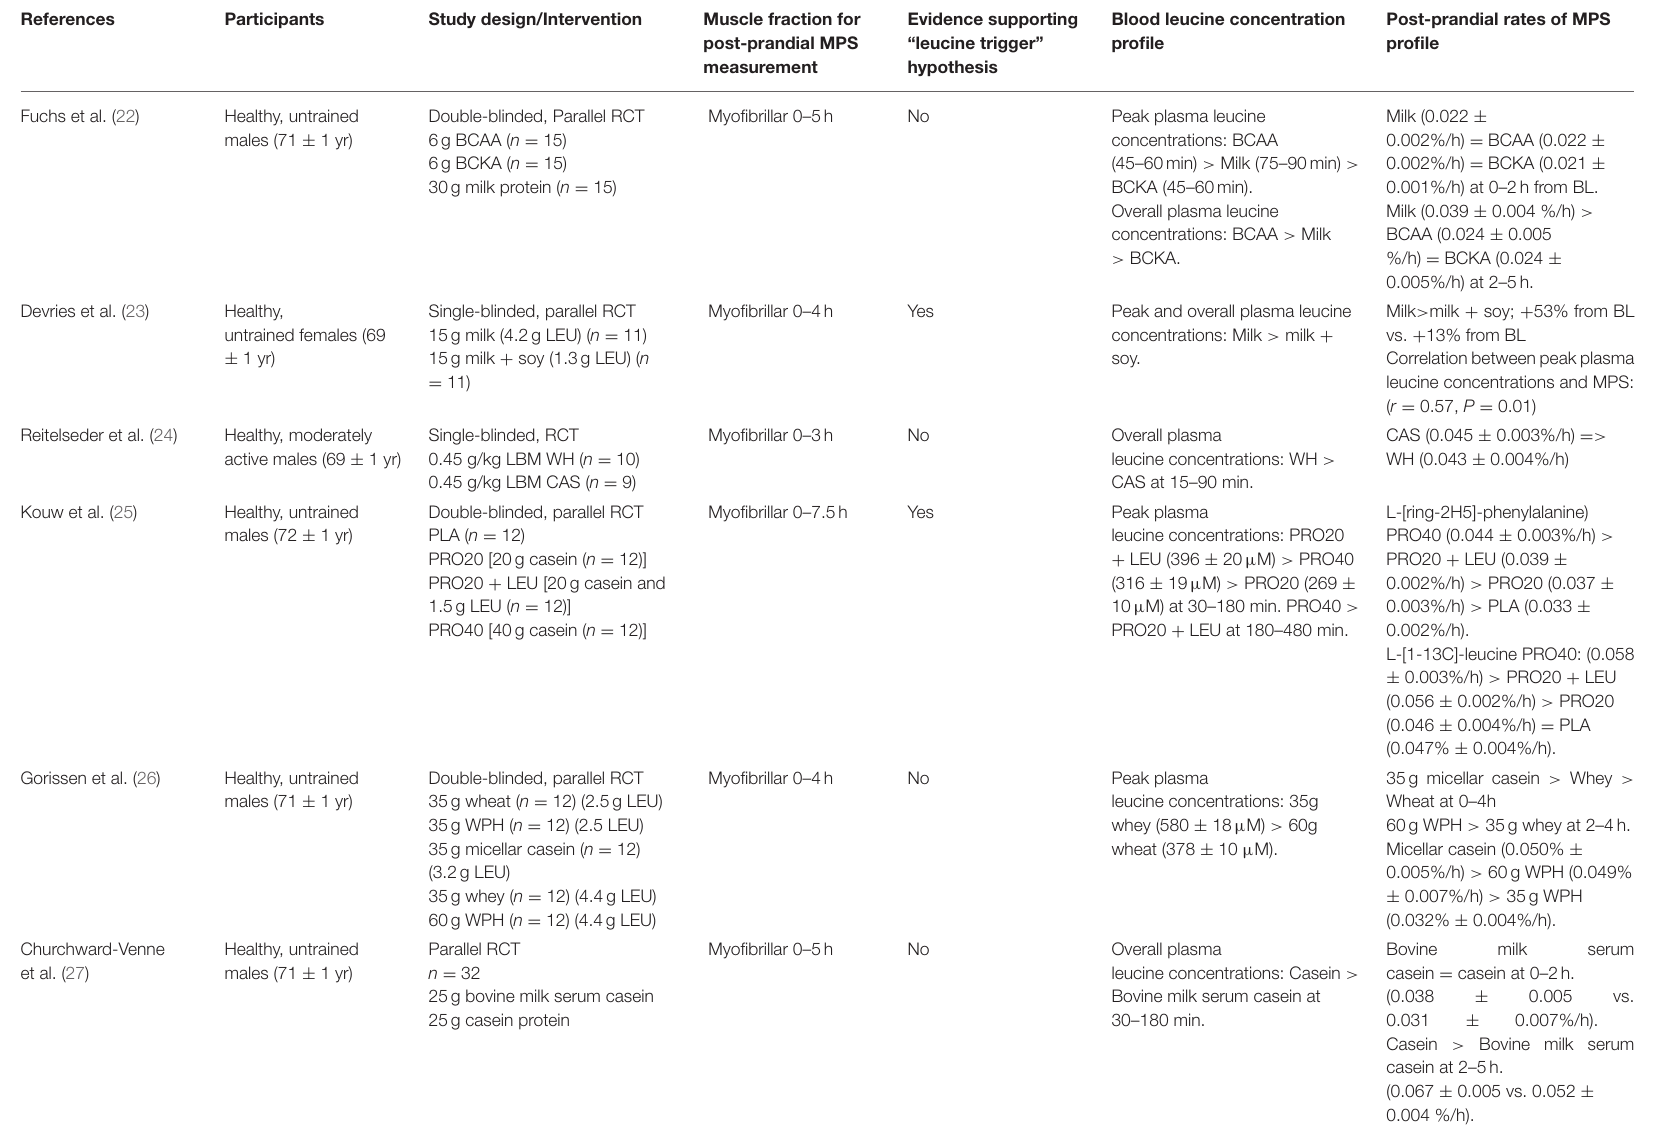
TABLE 1 | Summary of findings from studies that measured blood leucine concentration profiles and post-prandial rates of muscle protein synthesis at rest in older